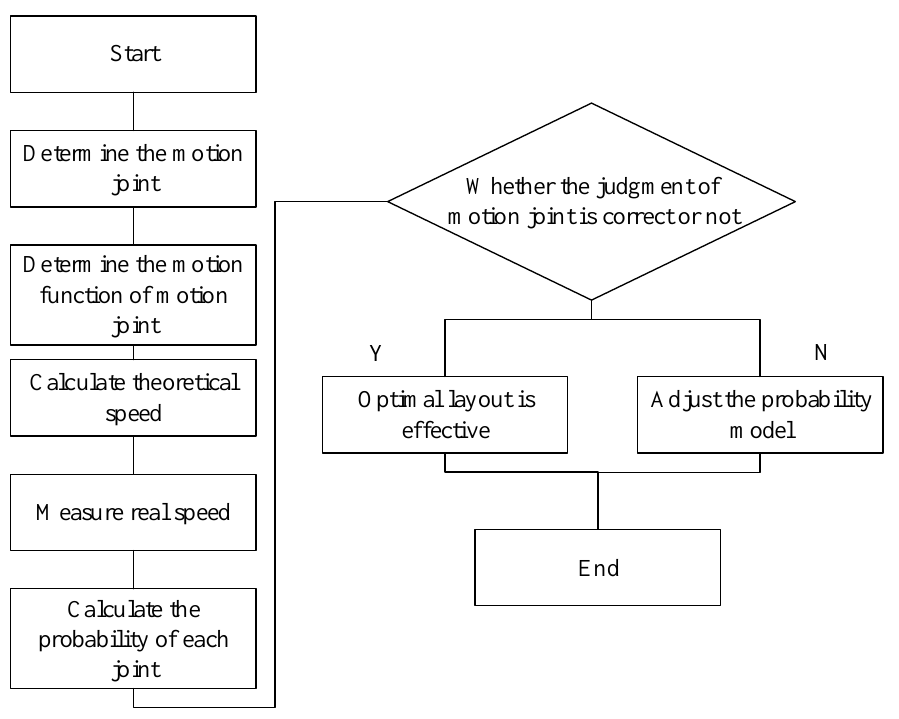
Figure 4. Flow chart of the layout verification method.